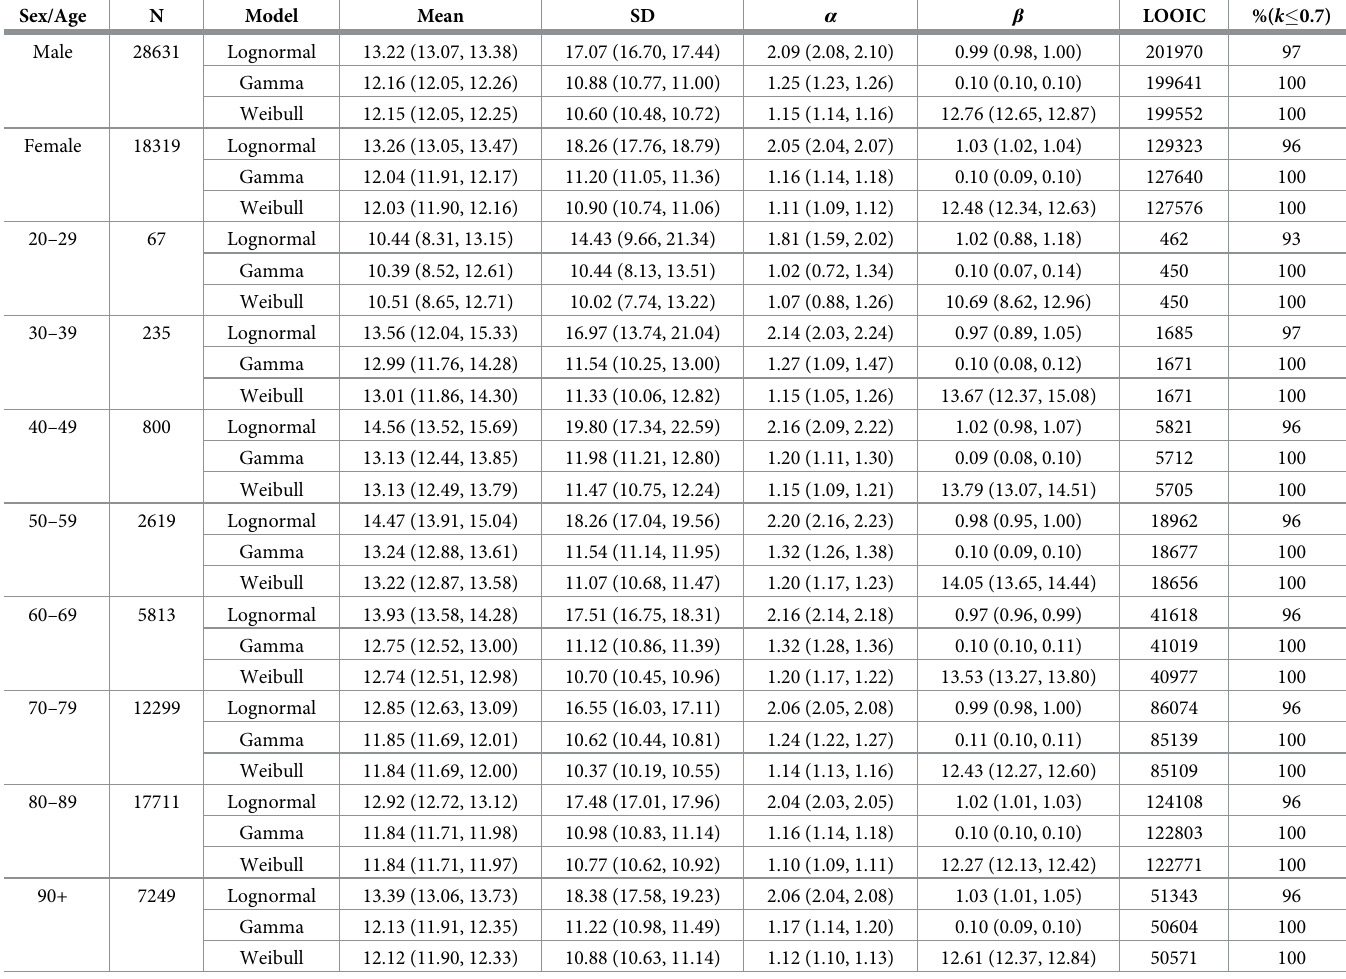
Table 6. Results for the time from hospitalisation to death by sex and